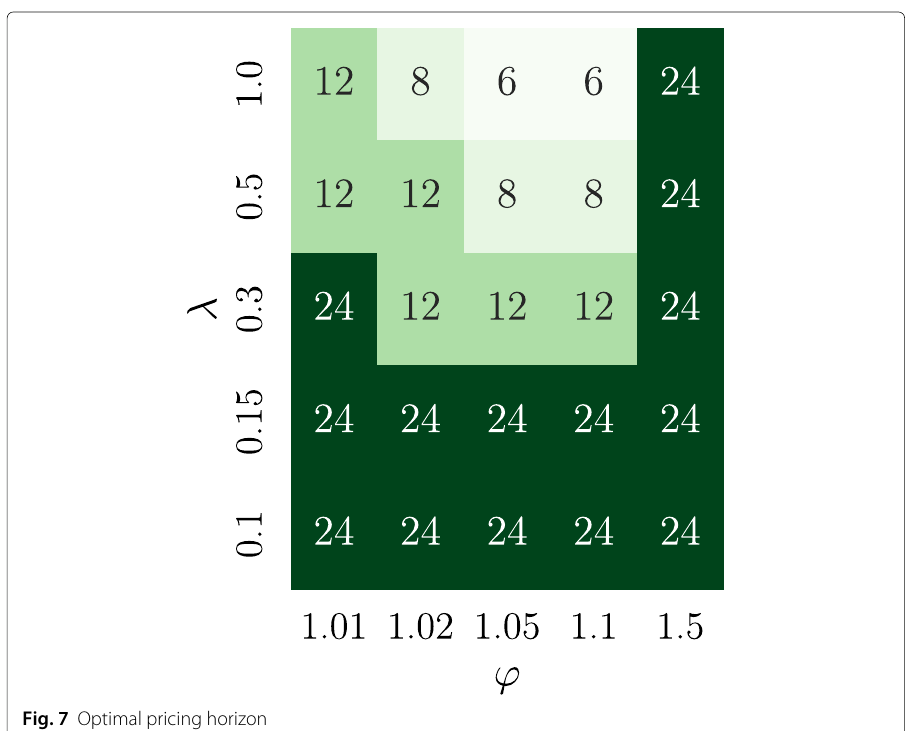
Fig. 7 Optimal pricing